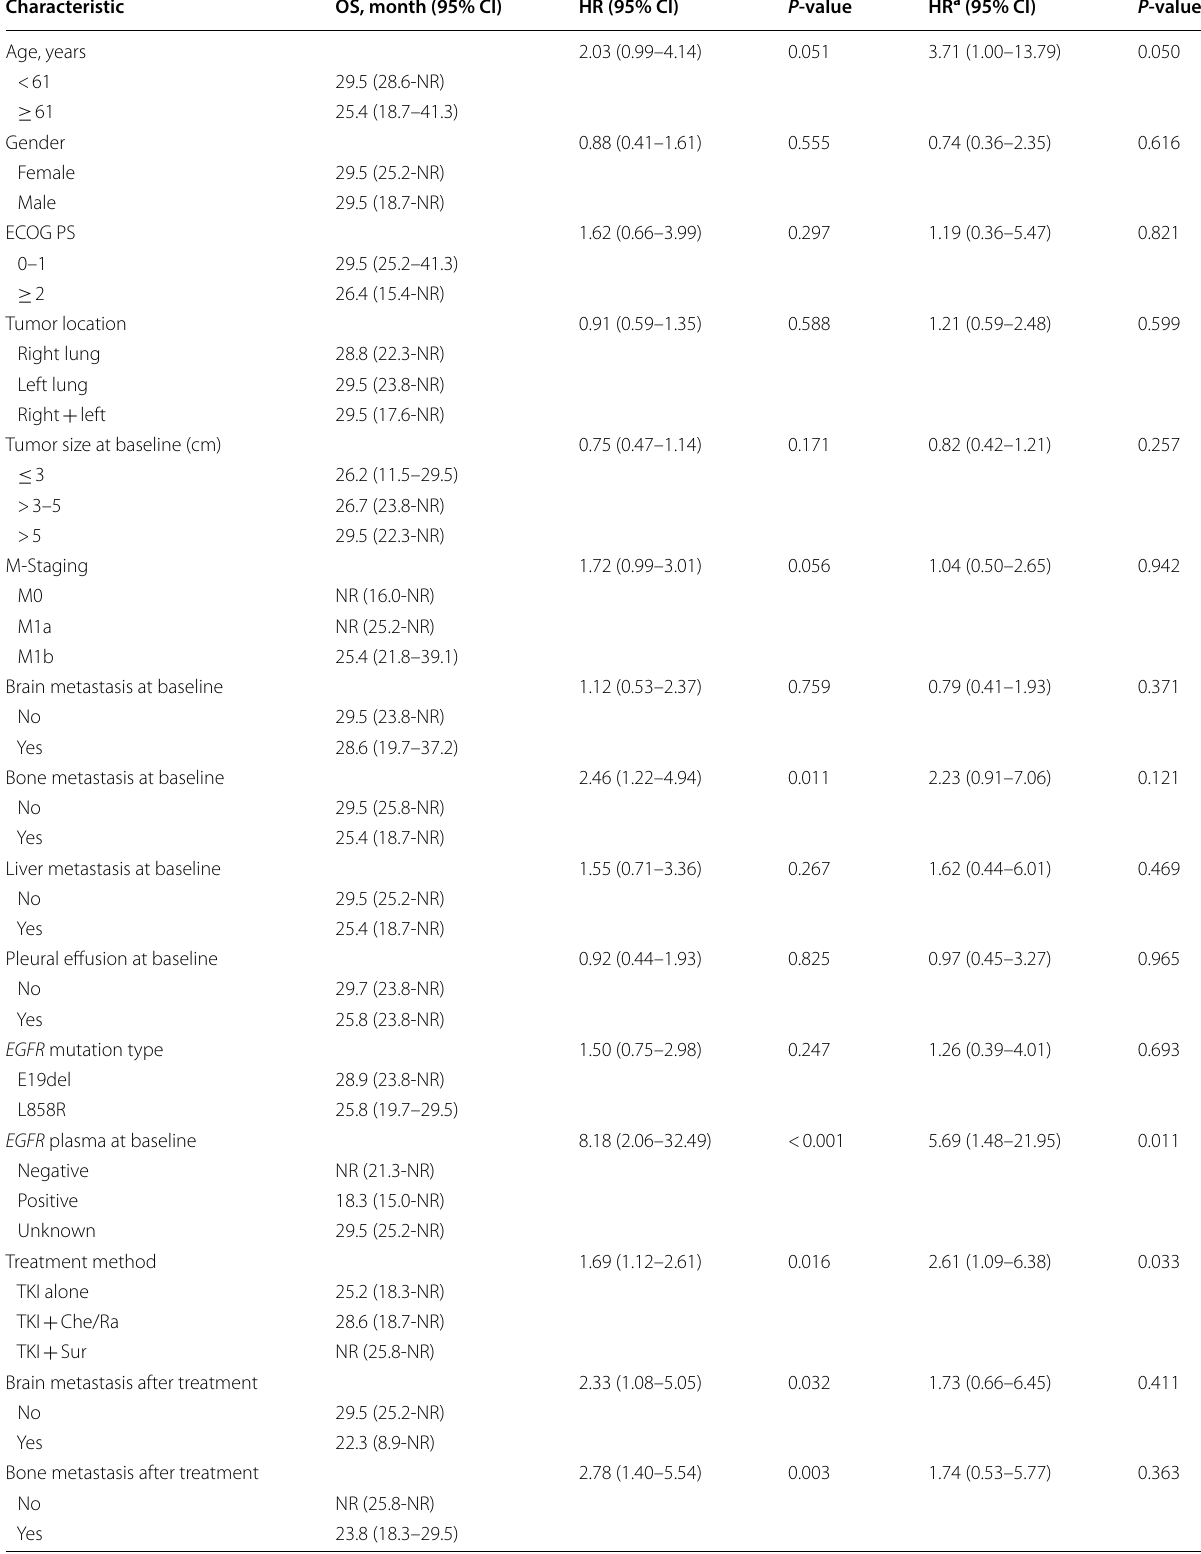
Table 4 Univariate analysis for overall